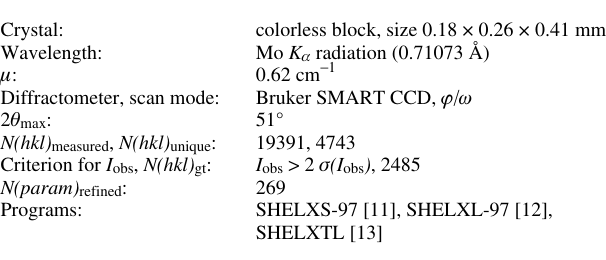
Table 1. Data collection and handling.